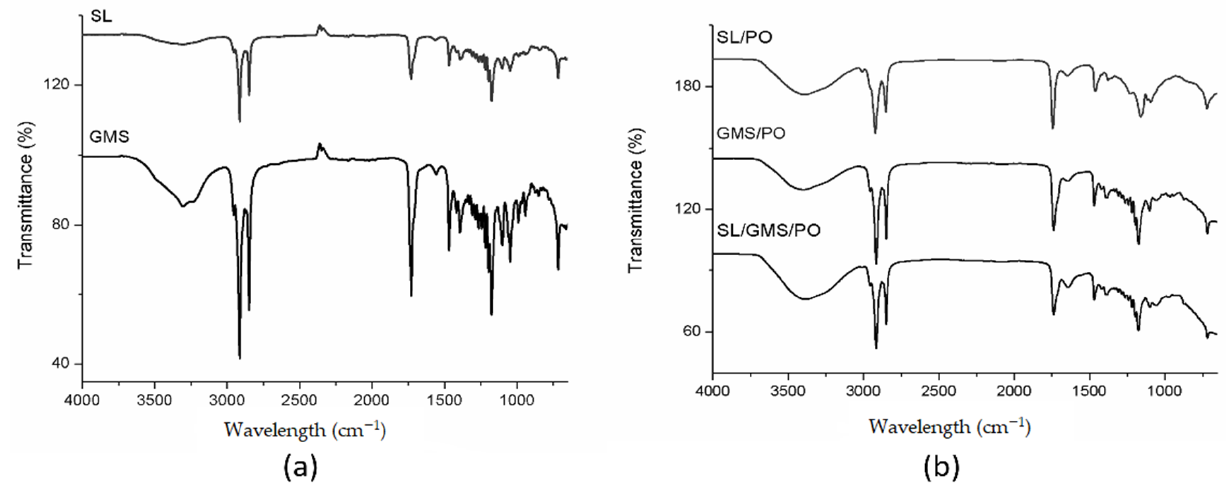
Figure 3. FTIR spectra of ( a ) pure organogelators and ( b ) SL/PO, GMS/PO, and SL/GMS/PO organogels. Figure 3b, which likely indicate presence of hydrogen bonding between the